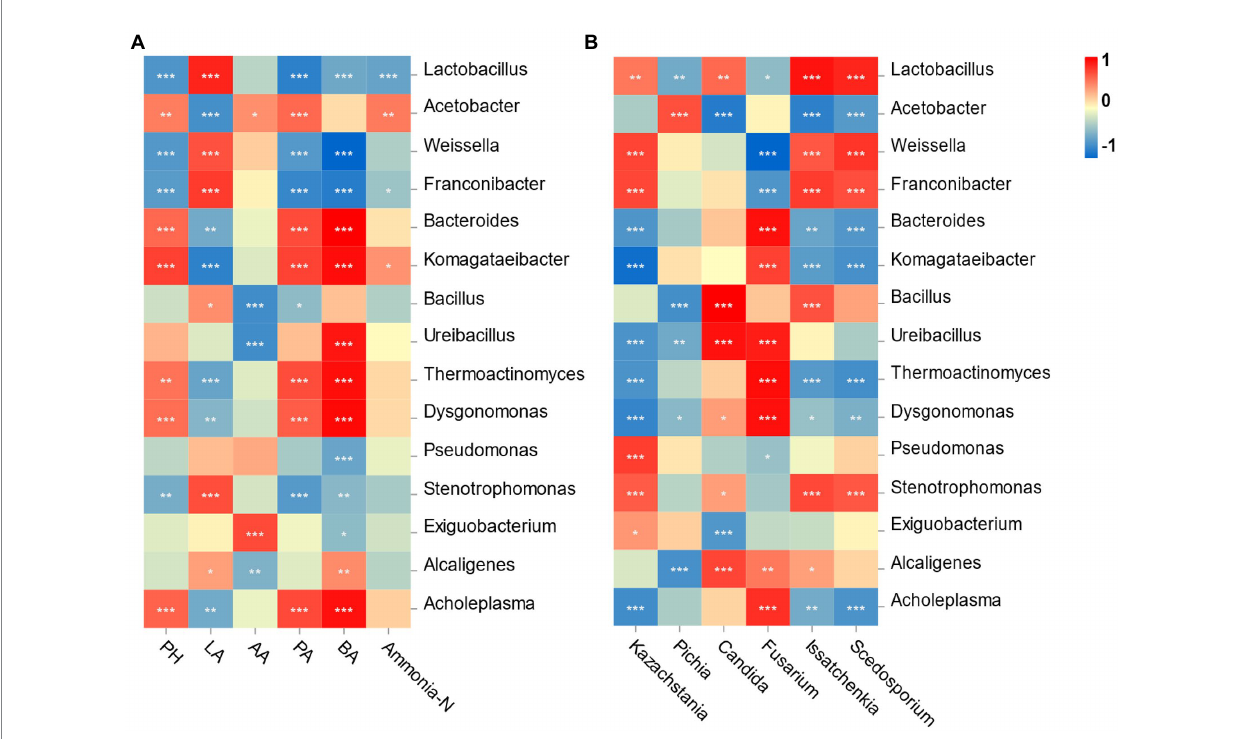
FIGURE 5 Correlation analysis of the bacterial genus with fermentation characteristic and the top 6 fungi genus. (A) X and Y axis are fermentation factors and bacterial genus, respectively; (B) X and Y axis are genera of fungi and bacteria, respectively. Red squares represent positive correlation (0 < r < 1), whereas blue squares represent negative correlation ( − 1 < r < 0). The value of p < 0.05 is marked with “*,” p < 0.01 is marked with “**,” p < 0.001 is marked with